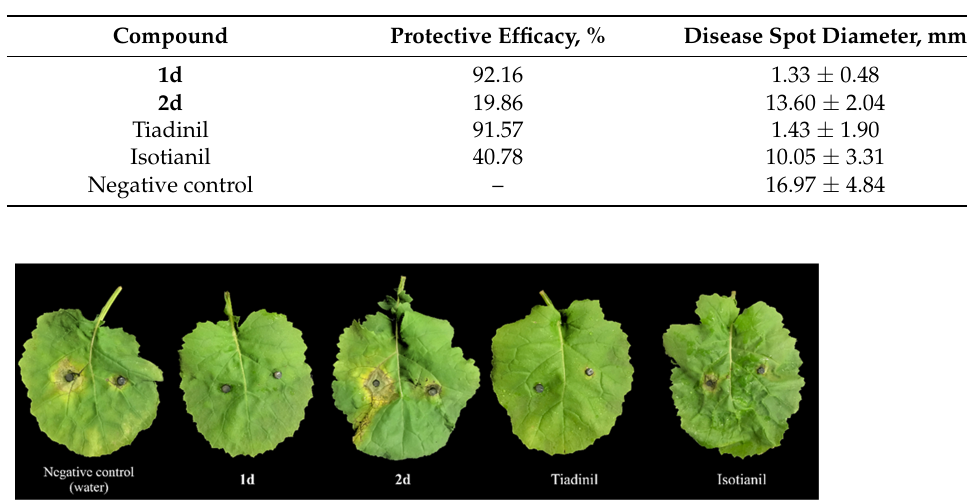
Table 4. In vivo efficacy of compounds on rape leaves infected by A. brassicicola .